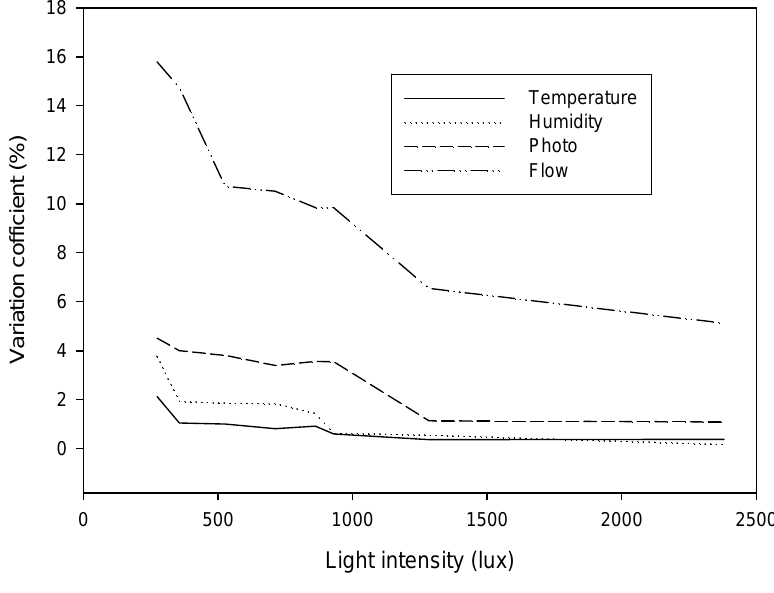
Figure 5. The variation coefficient of the measurement precision of the energy harvested sensor nodes with respect to different environmental light